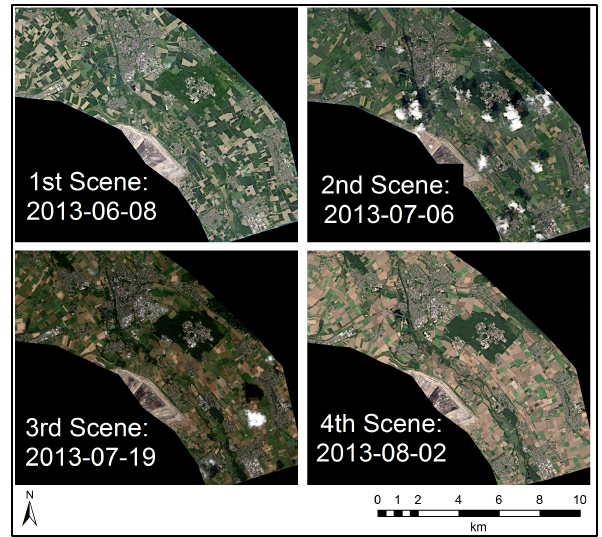
Figure 1. Overview of the four acquired WorldView-2